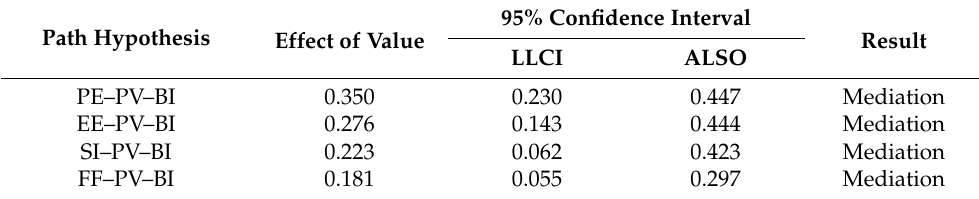
Table 6. Mediating effect